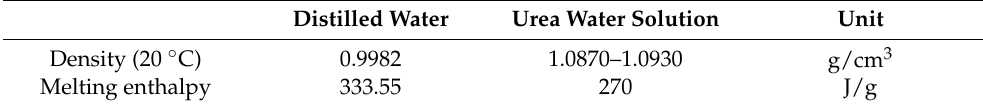
Figure 5. Visualization of frozen solution: ( a ) Urea water solution; ( b ) Distilled water. Table 2. Specifications of Solution.